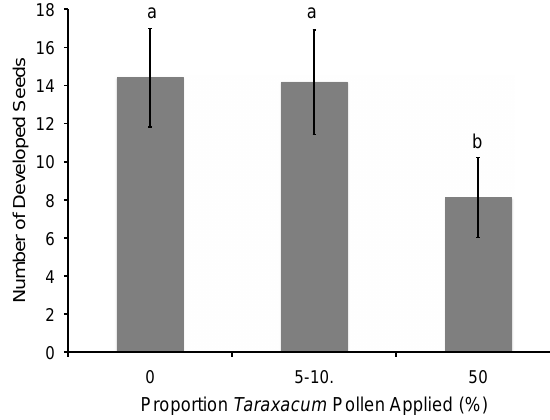
Figure 2. Seed set in Erysimum capitatum flowers when hand- pollinated with mixtures of conspecific and varying amounts of Taraxacum officinale pollen. Error bars represent the standard errors. Different letters indicate significant differences between groups. n=29 for the 0% treatment group, n=28 for the 5-10% treatment group, and n=25 for the 50% treatment